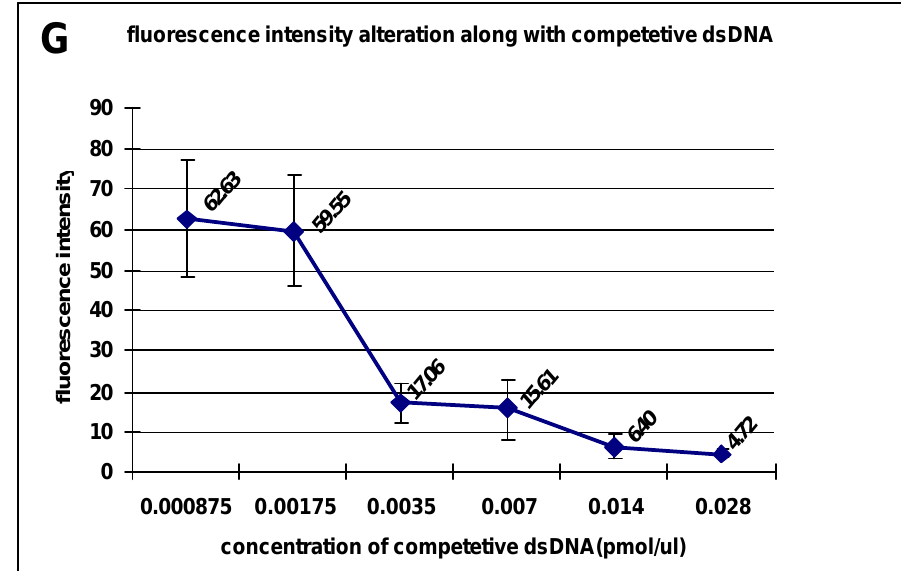
Figure 5. Fluorescence images and intensity plot of 6 dsDNA microarrays containing 6×7 NF- k B TOs which were hybridized with 6 variant binding reactions containing same concentrations of Cy3-labeled NF- k B protein but 6 different concentrations of cold free NF- k B dsDNA consensus oligonucleotides (Promega) which nucleotide sequence was completely same as oligonucleotide NS in Table